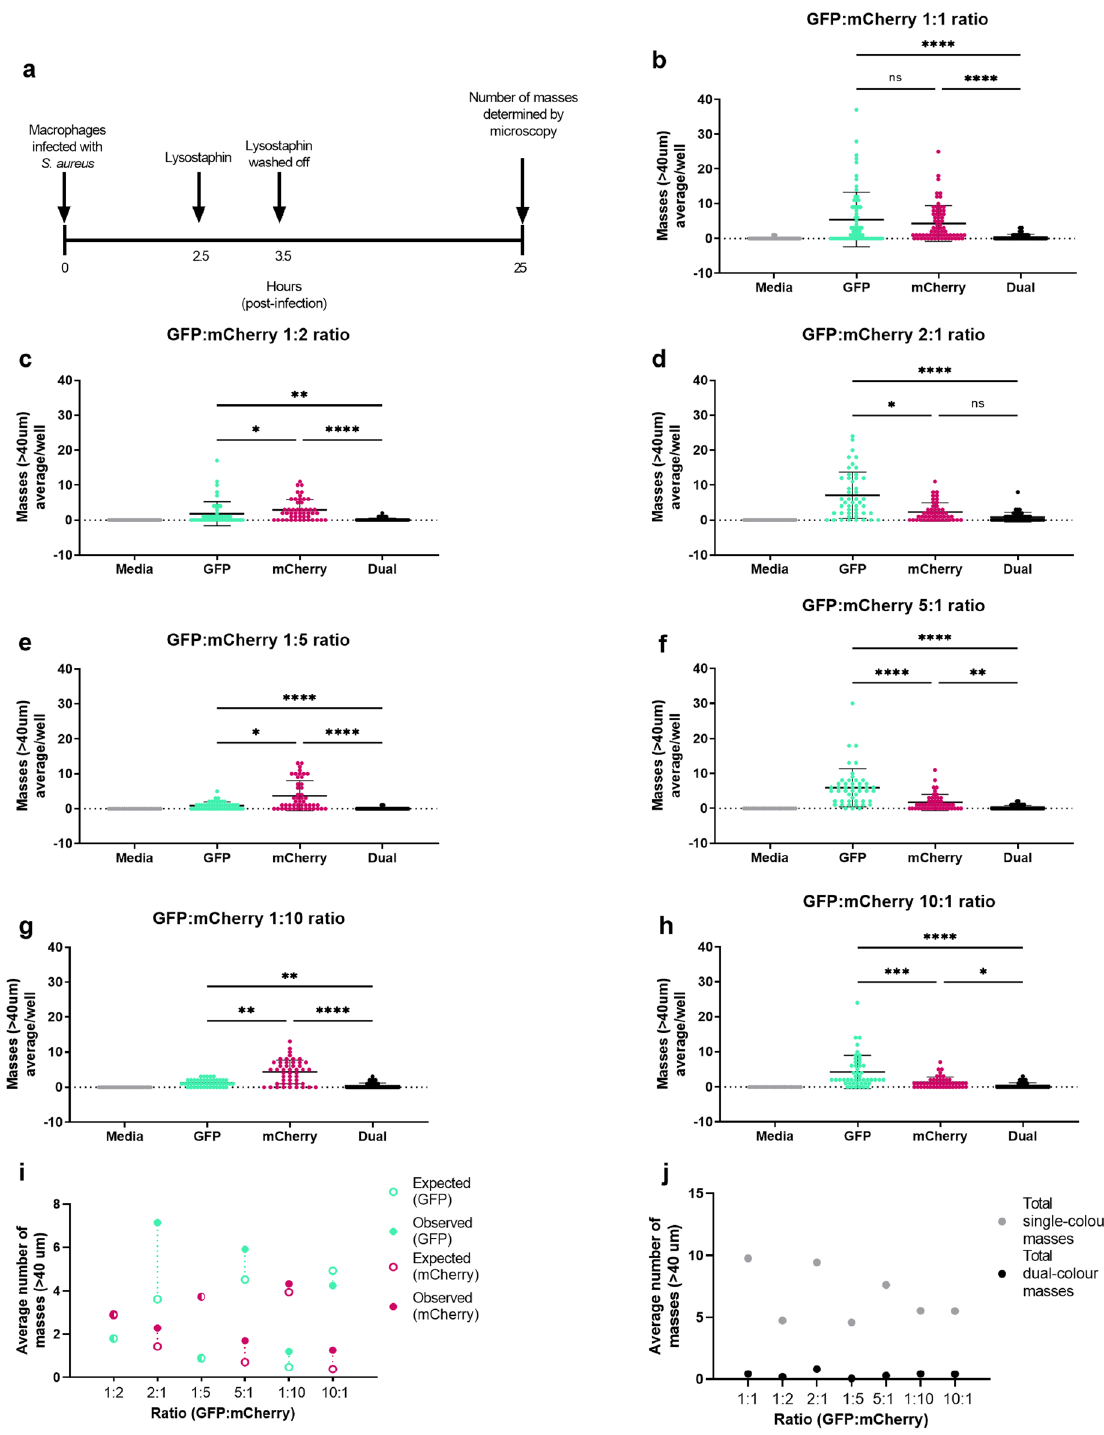
Figure 1. Altering the ratio of GFP:mCherry S. aureus influences resulting bacterial mass formation. ( a ) Diagram showing experimental overview. ( b – h ) RAW264.7 macrophages were infected with different ratios of GFP and mCherry marked S. aureus (total MOI 5). The number of single- or dual-colour bacterial masses detected at 25 h post-infection is indicated, error bars show mean values ± standard deviation, each data point represents a well. Ratios (GFP:mCherry): ( b ), 1:1 ratio ( n = 4); ( c ) 1:2 ratio ( n = 4); ( d ) 2:1 ratio ( n = 4); ( e ) 1:5 ratio ( n = 3); ( f ) 5:1 ( n = 3); ( g ) 1:10 ( n = 3); ( h ) 10:1 ( n = 3), * p < 0.05, ** p < 0.005, *** p < 0.0005, **** p < 0.0001, as determined using a Kruskal–Wallis test with Dunn’s post-hoc test. GFP (cyan), mCherry (magenta), media control (grey), dual (black). i , Comparison between expected (open circles) and observed (closed circles) mass numbers for ratio data presented in ( c – h ), with expected plots calculated based on 1:1 ratio data from b , dotted line depicts difference between expected and observed values. ( j – k ), Comparison between number of total single-colour (grey) and dual- colour masses (black) for ratio data presented in ( b – h ): ( j ), summary of average plots for ( b – h